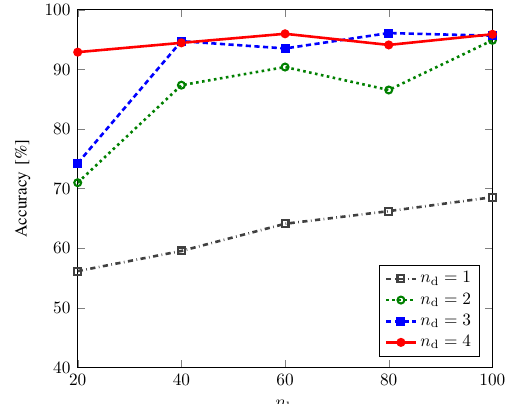
Figure 8. Classification accuracy of the Bell-DNN ( 8, n d , n h ) model as a function of the number of hidden neurons, n h for Svetlichny features when n d =